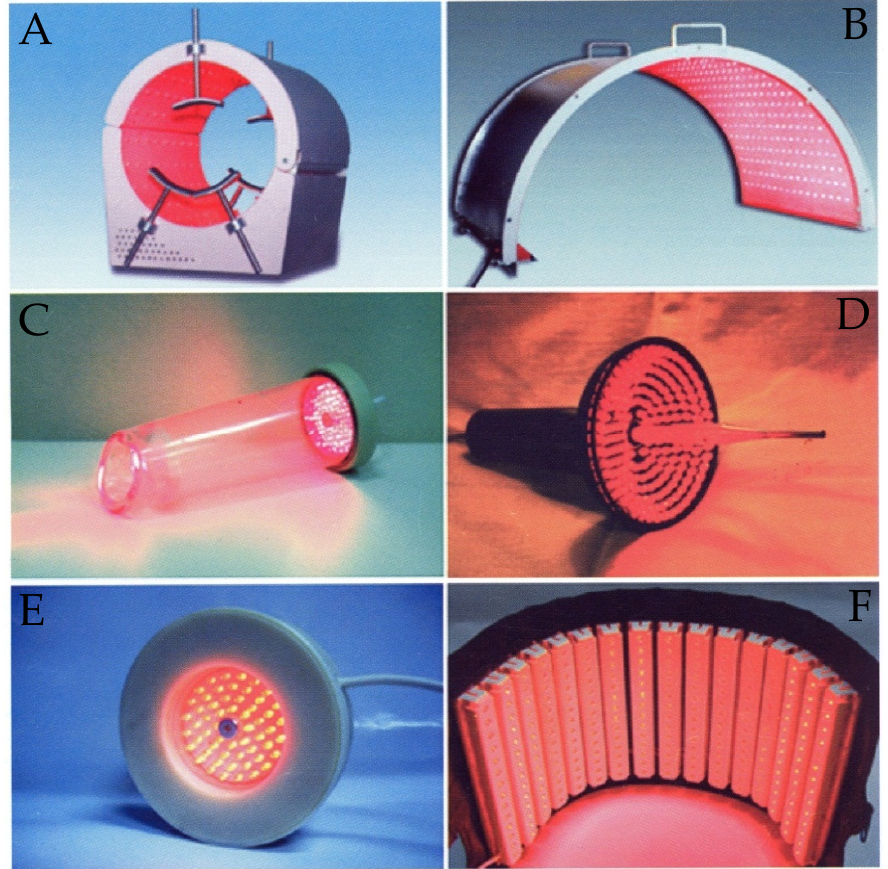
Figure 1. Varieties of photomatrix therapeutic systems (description of pictures is provided in text).